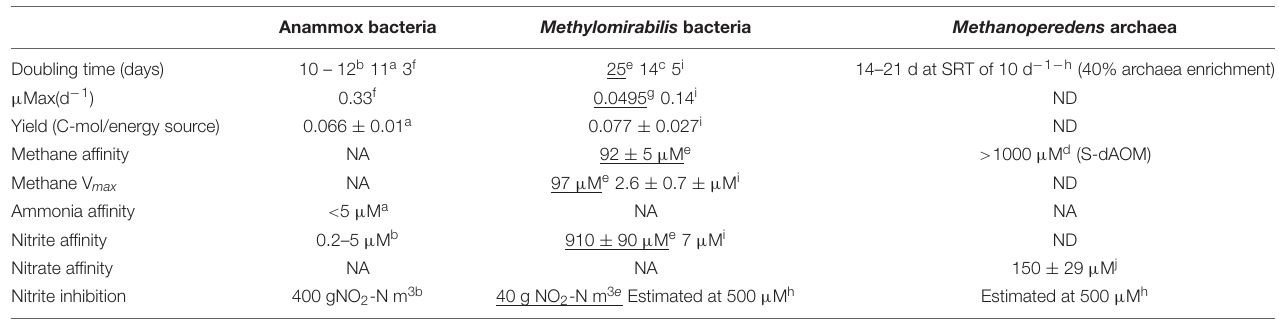
TABLE 1 | Summary of relevant physiological parameters of both anaerobic ammonia and methane-oxidizing